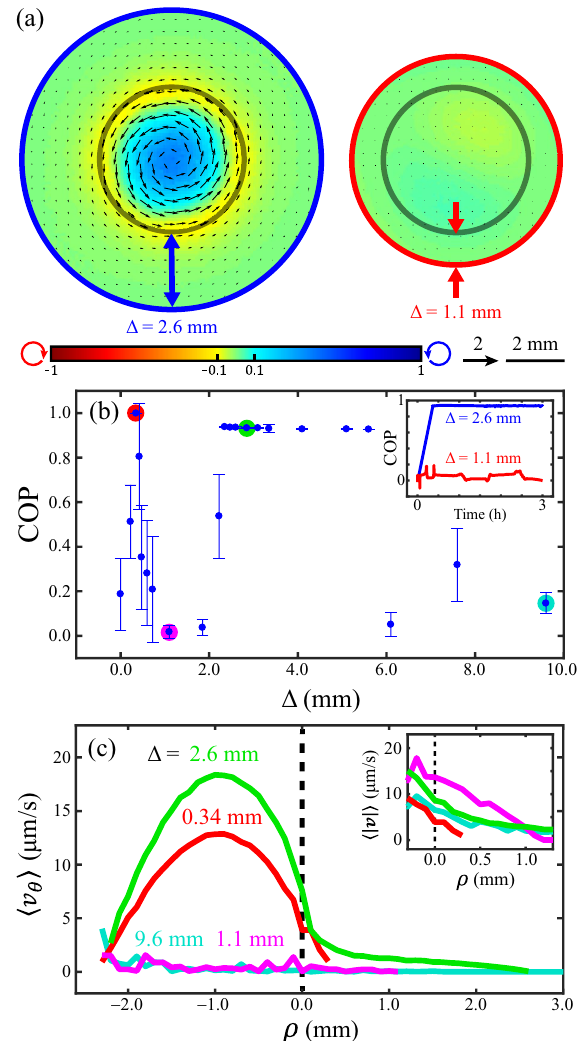
Figure 6. Simulation of behavior of compressed water-in-oil droplets based on continuum active fluid equations. ( a ) Simulated time-averaged velocity fields and vorticity maps from the midplanes of compressed droplets ( r 2.4 mm, h 2 mm) immersed in oil layers of different thicknesses ( (cid:31) ). The velocities and = = vorticities were plotted as in Fig. 1c. Gray curves represent the water–oil interfaces; blue and red curves represent the no-slip boundaries. Droplets immersed in a thicker oil layer ( (cid:31) 2.6 mm) developed circulatory = flows (left), whereas in those with a thinner oil layer ( (cid:31) 1.1 mm) the circulatory flows were suppressed (right). = Simulated instantaneous velocity fields and vorticity maps in xy -, yz -, and xz -midplane cross-section for various oil layer thicknesses are available in Supplementary Fig. S6. ( b ) Circulation order parameter (COP) as a function of the layer thickness of the oil that surrounds a compressed droplet ( r 2.4 mm, h 2 mm). The intradroplet = = flows were sensitive to oil layer thickness when the thicknesses were thinner than ~ 2.2 mm. Each error bar represents the standard deviation of the time-averaged COP. Inset: Evolution of COPs within the droplets described in panel a . ( c ) Flow profiles of azimuthal velocities, v θ , taken at droplet midplanes. The horizontal axis represents the radial axis in cylindrical coordinate with the origin shifted to the droplet interface (Fig. 5c inset). Each curve represents the averaged flow velocity of the data points shaded in the same color in panel b . Dashed lines represent the water–oil interface. These flow profiles demonstrated that intradroplet circulatory flows induced a thin layer (0.3–2 mm) of circulatory flow in the oil near the interface, indicating that flows within and outside the interface were coupled. Inset: Flow speed profiles near the droplet